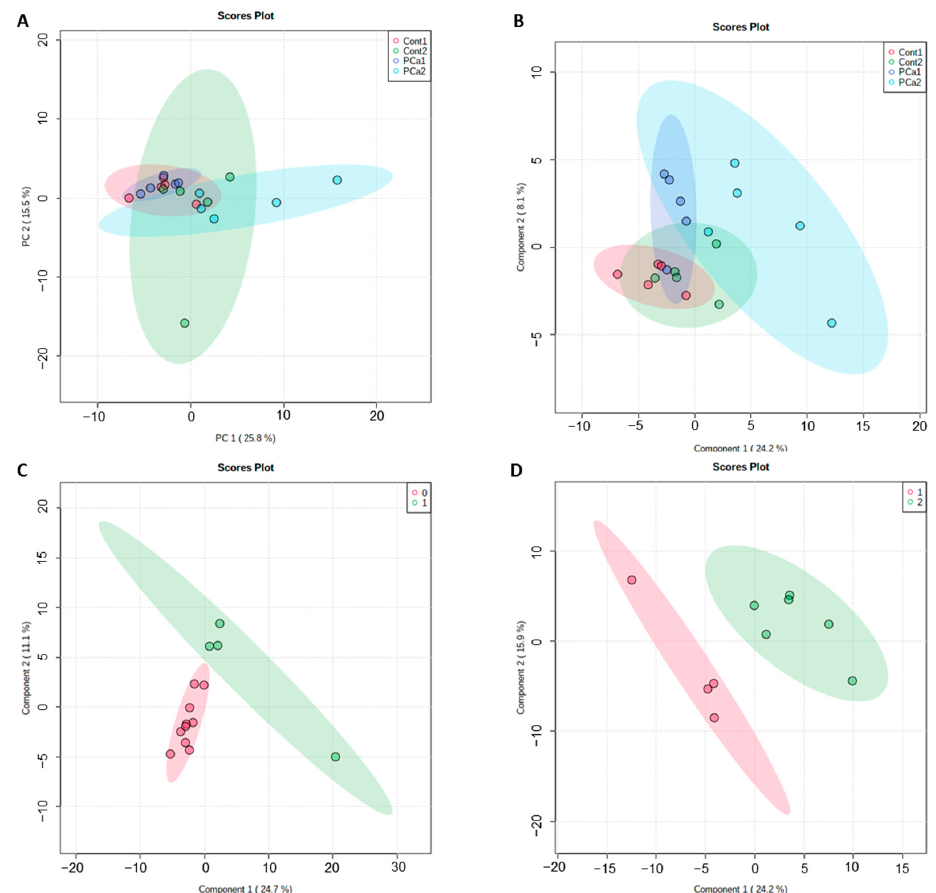
Figure 1. ( A ) Principal component analysis (PCA) and ( B ) partial least squares discriminant analysis (PLS-DA) of urine proteome data from animal groups (Cont1, PCa1, Cont2 and PCa2; five animals per group). Pairwise PLS-DA of urine proteome data among sequential prostate histological score ( C ) 0 and 1 and ( D ) 1 and 2.